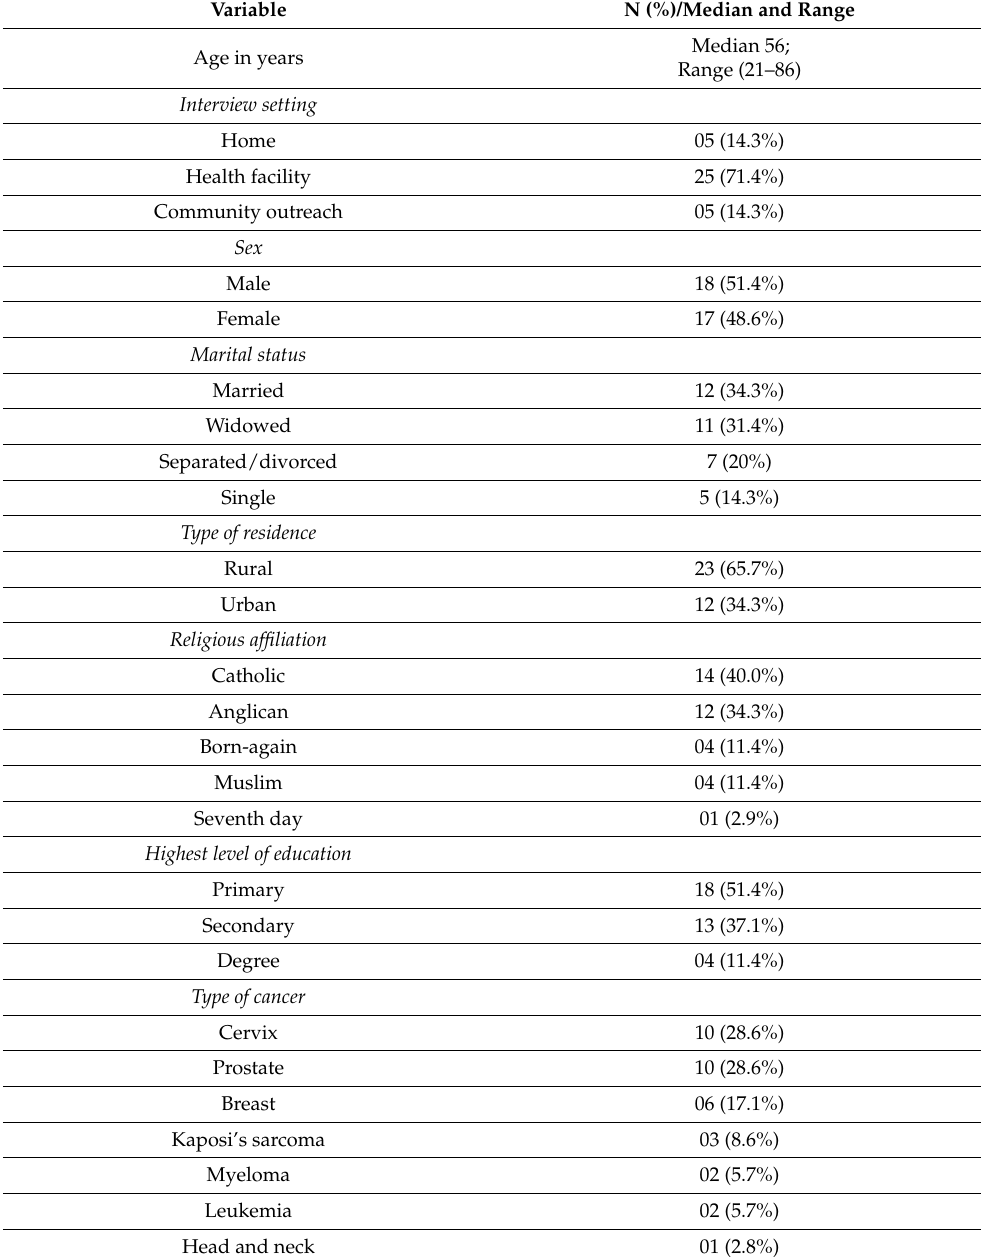
Table 1. Socio-demographic characteristics of the study